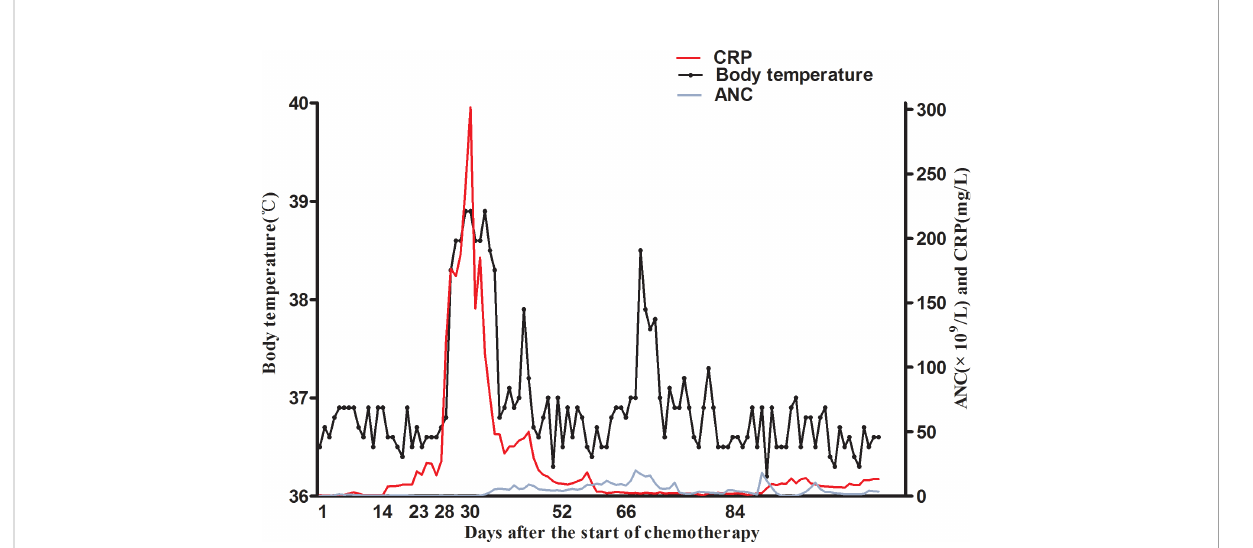
FIGURE 3 The clinical course of the patient. The patient had fever on day 28 and persistent fever for several days. Fever subsided after amphotericin B and posaconazole treatment. The ANC and CRP data were also obtained. The temperature was gradually increased on day 23 and peaked on day 34. A blood count revealed persistence of neutropenia and severe neutropenia on day 30. On day 66, surgical management was performed. On day 84, the patient started the second induction therapy.